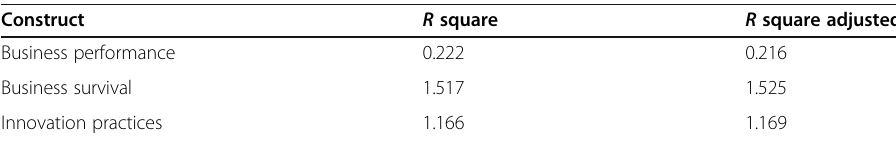
Table 4 Variance explained